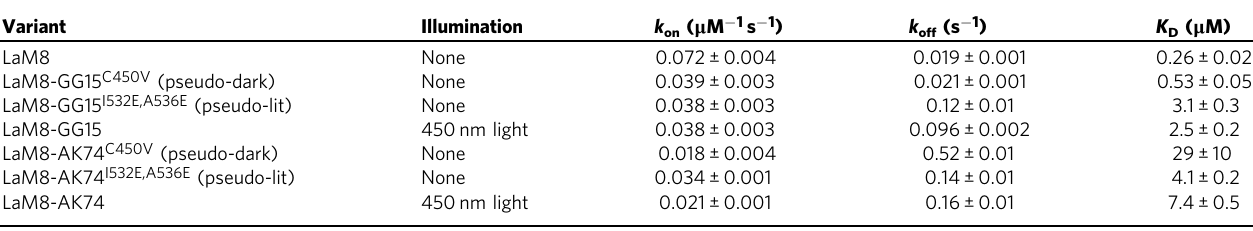
Table 1 Binding measurements for lit- and dark-state OptoNBs.